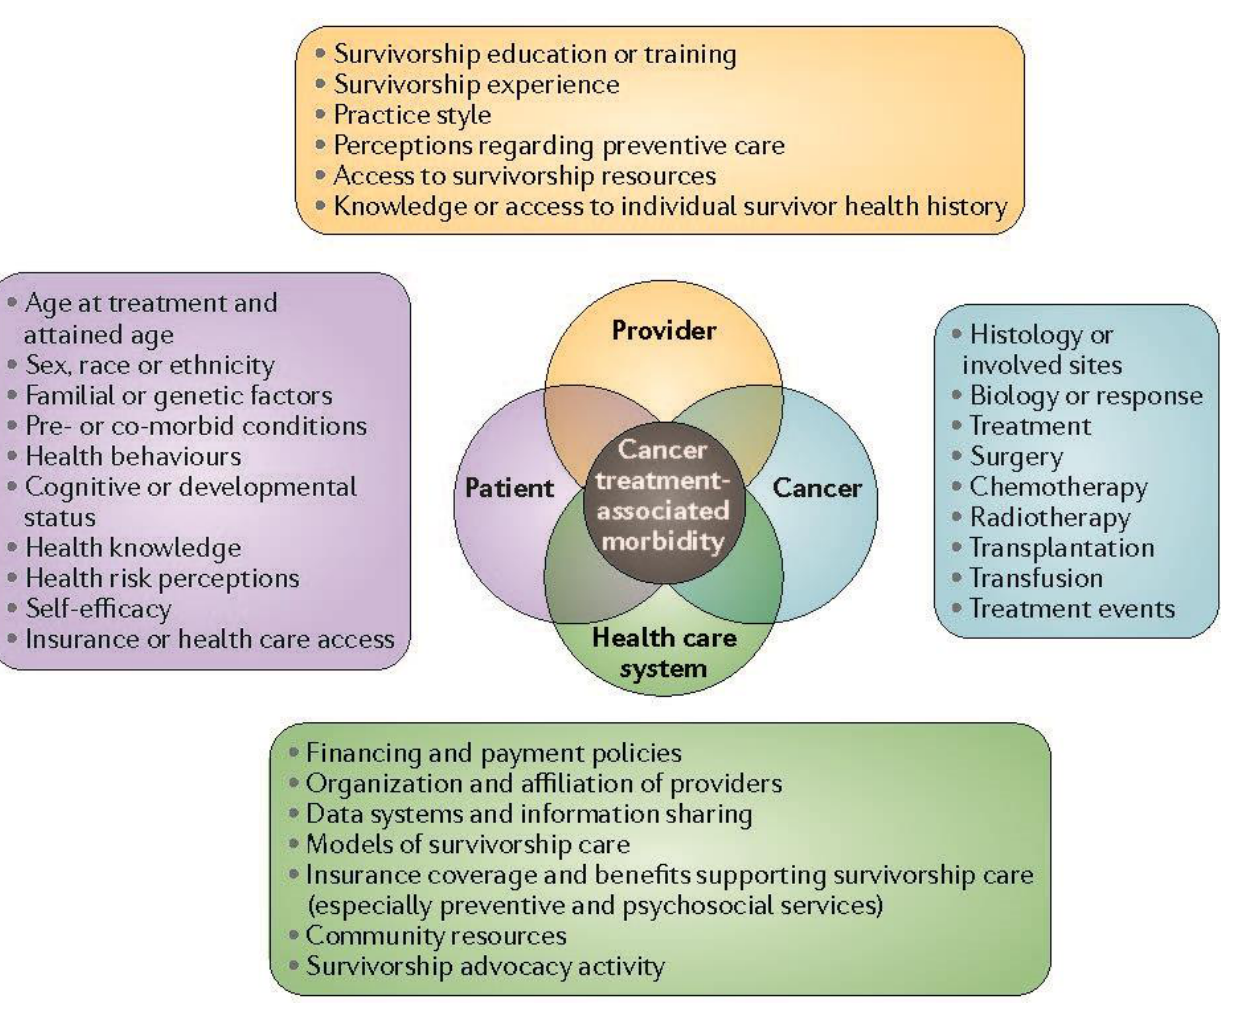
Figure 2. Range of health-related and quality-of-life outcomes among long-term survivors of childhood and adolescent cancers. This figure shows some of the issues that are faced by survivors of childhood and adolescent cancers. GI, gastrointestinal. Reprinted with permission from Robison L.L. and Hudson M.M.